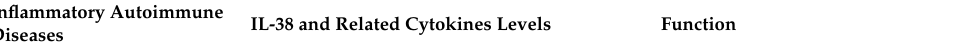
Table 2. IL-38 and its related cytokine expression and function in inflammatory autoimmune